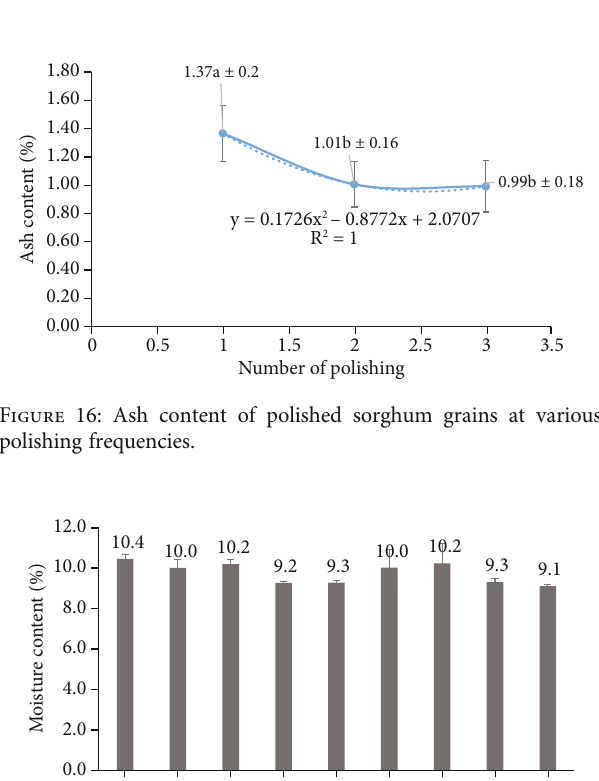
Figure 15: Ash content of three varieties of polished sorghum.